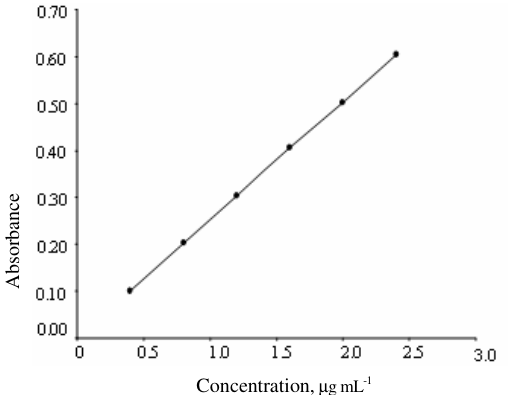
Figure 2. (b) CEFT - NBS/CB system; Beer’s law plot.